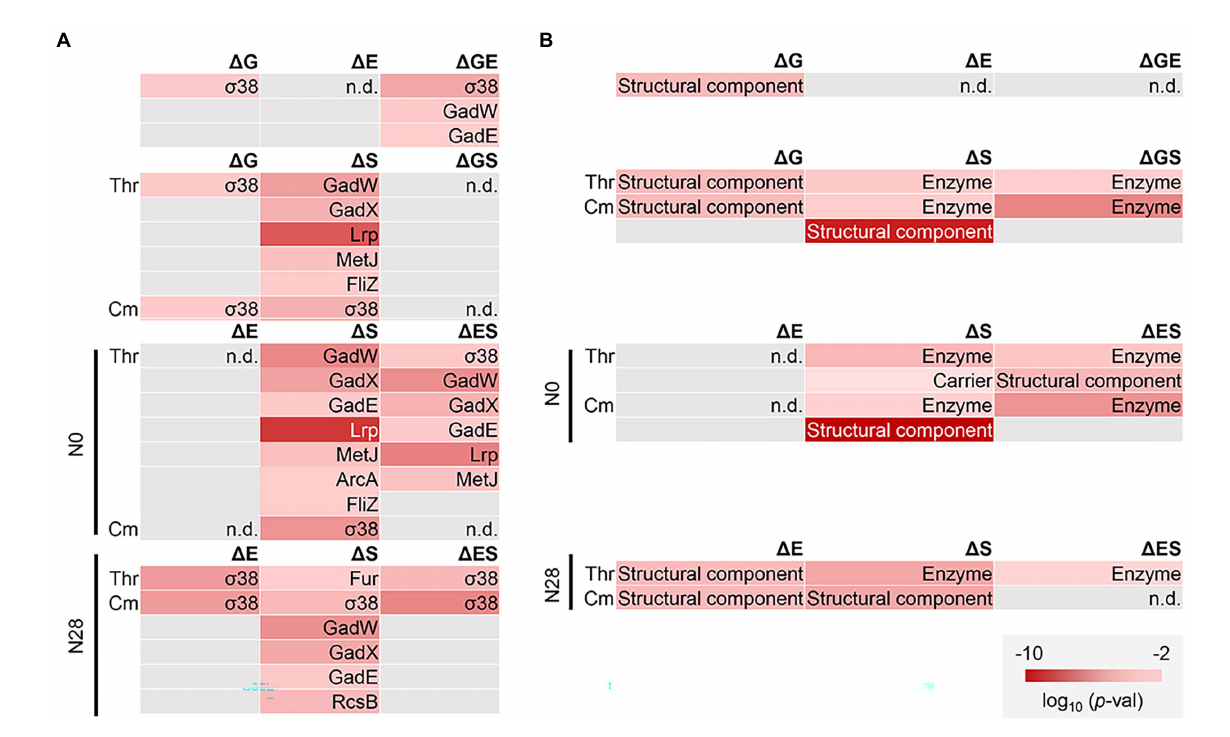
FIGURE 6 Functional enrichment of DEGs. (A) Regulon enrichment. Statistically significant regulons are shown. (B) Gene category enrichment. Statistically significant gene categories are shown. Gradation in red indicates the normalized p values in the logarithmic